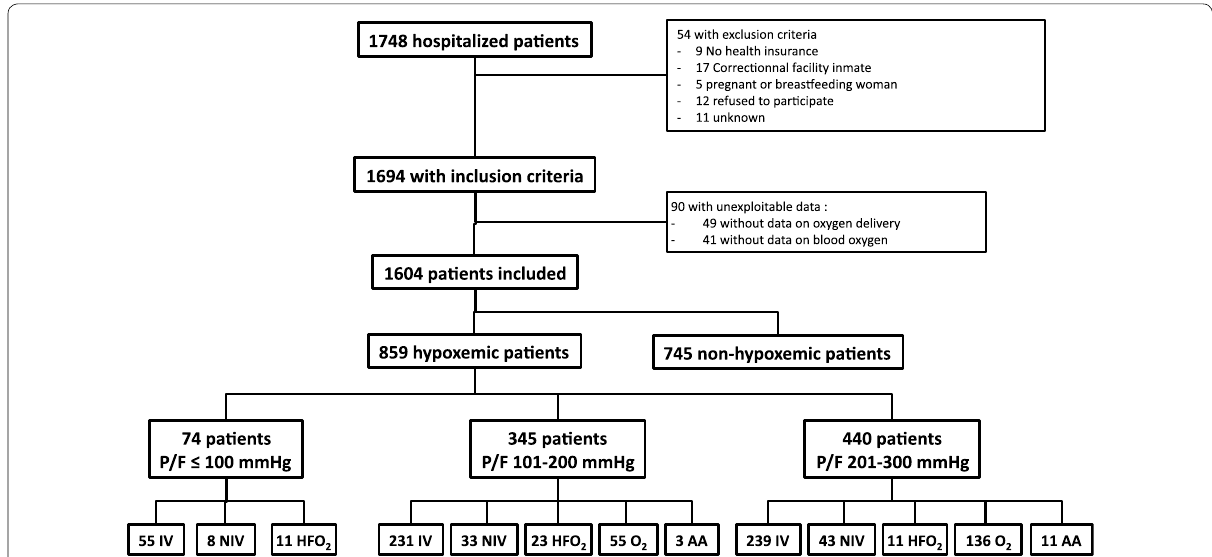
Fig. 1 Flowchart of the study. P / F : PaO 2 /FiO 2 ratio; IV: invasive ventilation, NIV non-invasive ventilation, HFO 2 : high-flow oxygen therapy, O 2 : low-flow (standard) oxygen therapy, AA: ambient